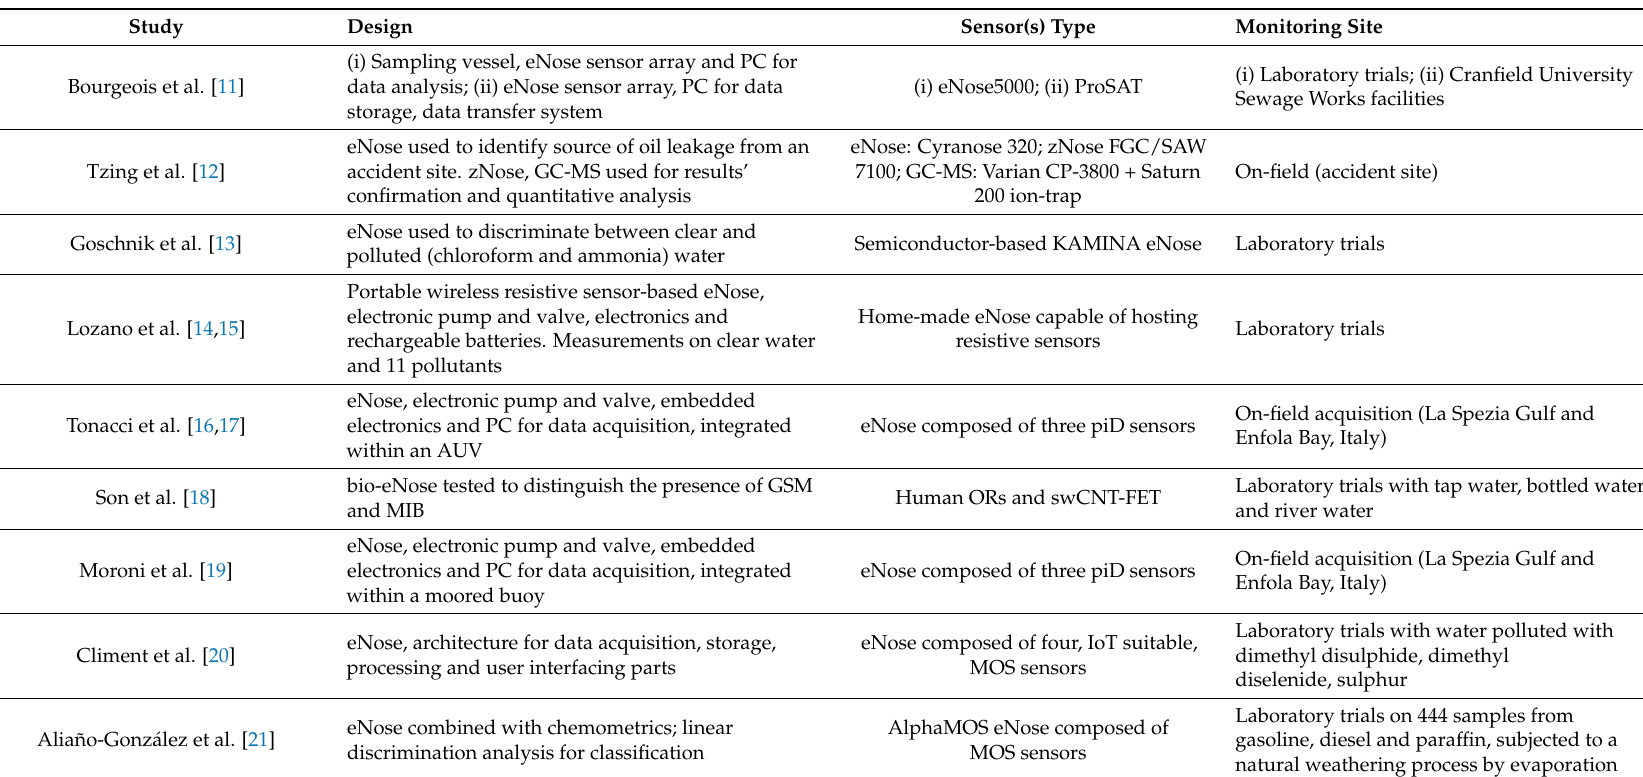
Table 1. Study selected (AUV: autonomous underwater vehicle; FGC: fast gas chromatography; GC-MS: gas chromatography—mass spectrometry; GSM: geosmin; IoT: Internet of Things; MIB: 2-methylisoborneol; MOS: metal oxide semiconductor; ORs: olfactory receptors; piD: photo-ionization detector(s); swCNT-FET: single-walled carbon nanotube field-effect